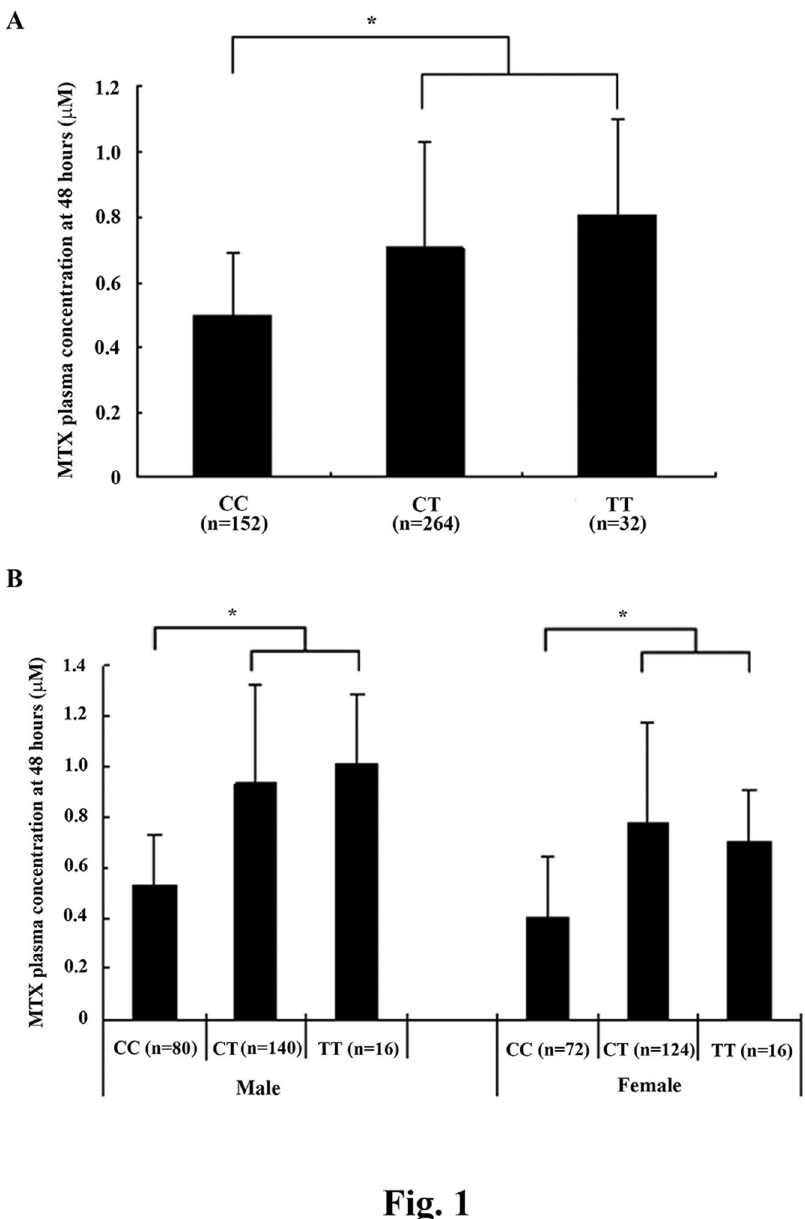
Figure 1. Methotrexate (MTX) plasma concentrations by ATP-binding cassette subfamily C member 2 ( ABCC2 ) 2 24C . T polymorphism genotypes. MTX plasma concentrations were measured at 48 hours after initiation of MTX infusion and shown by the ABCC2 2 24C . T polymorphism genotypes alone ( A ) or further stratified by gender ( B ). * p , 0.05 vs CC.